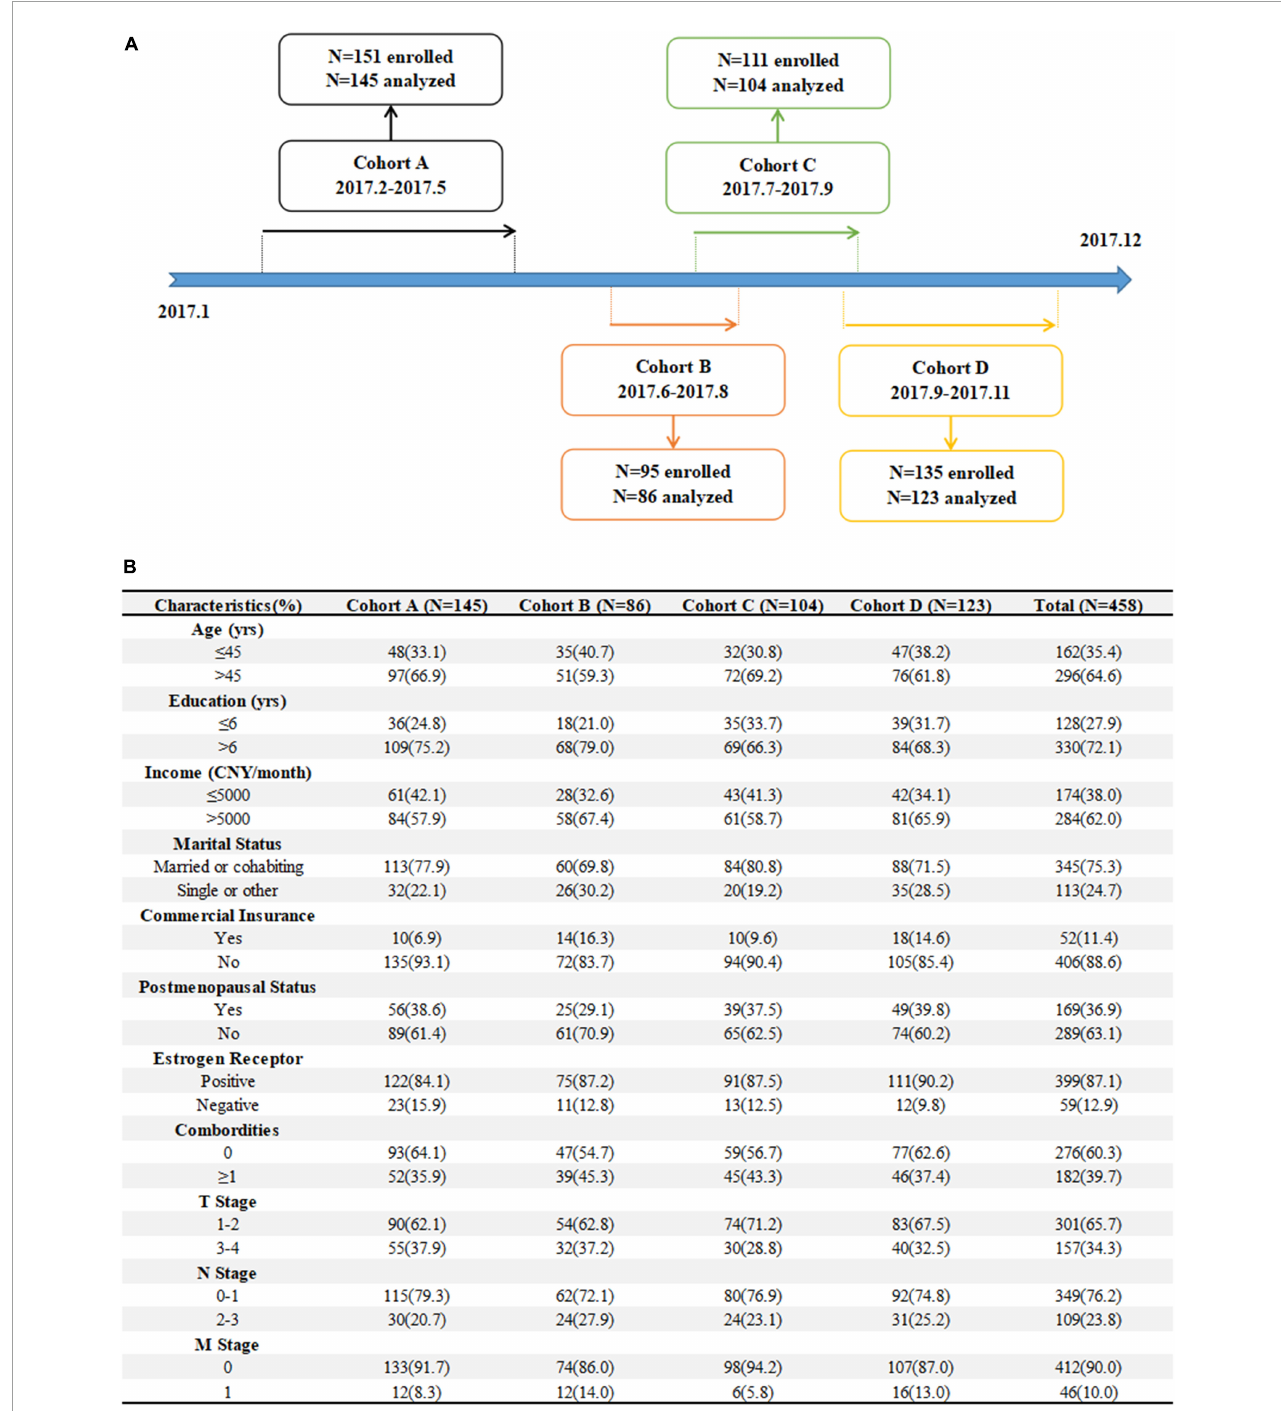
FIGURE1 (A) The enrollment line (B) and demographics for patients.